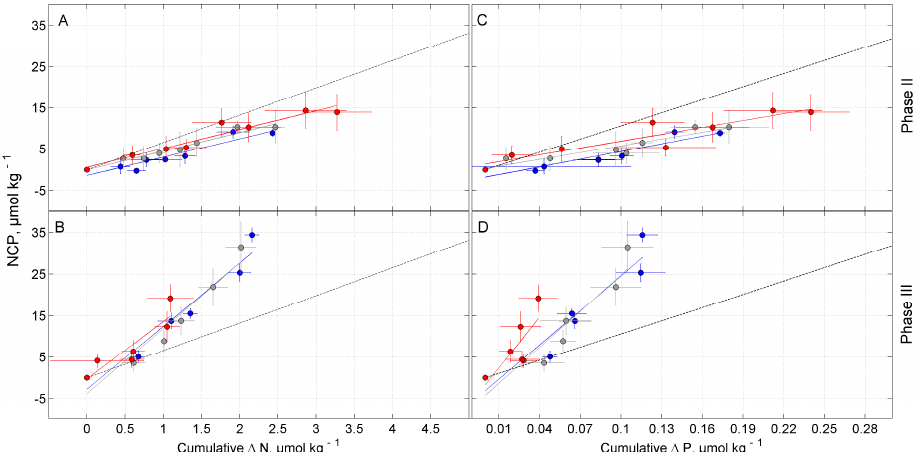
Figure 7 Fig. 7. Ratios of net community production to a cumulative change in inorganic nitrogen (A) and phosphorus (C) in phase II and phase III (B) , (D) (C:N and C:P uptake ratios). Data and slopes are averaged for low (blue), intermediate (grey) and high (red) p CO 2 treatment. Error bars are 1 standard deviation. Slopes were calculated with linear regression analysis (see Methods section for details). Slopes of linear regression analysis and statistics of the F test are shown in Table 3 for C:N uptake ratio and in Table 4 for C:P uptake ratio. Dashed black lines are the Redfield C:N and C:P elemental